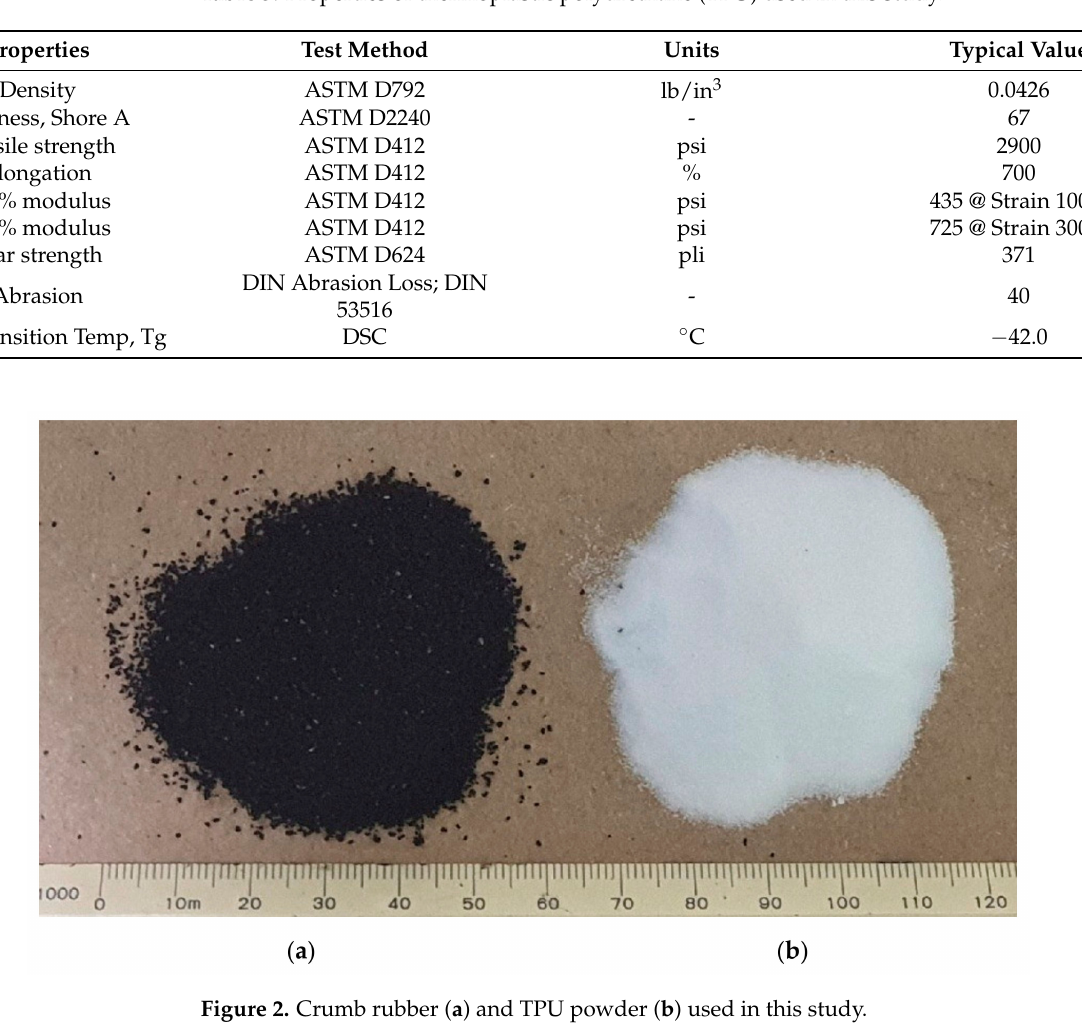
Table 3. Properties of thermoplastic polyurethane (TPU) used in this study.